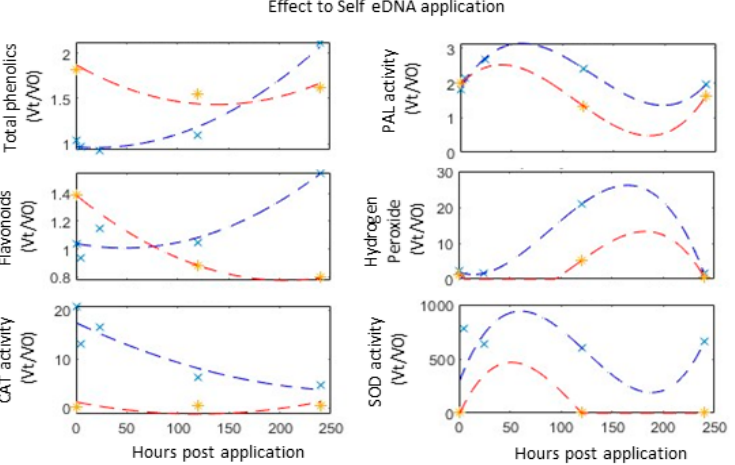
Figure 2. Mathematical Modeling of plant immune responses to self eDNA. Data showed in nor- malized dimensionless values for each sampling time in hours post-treatment application. Blue lines represent responses to first application and red lines represent responses to second application of treatment.